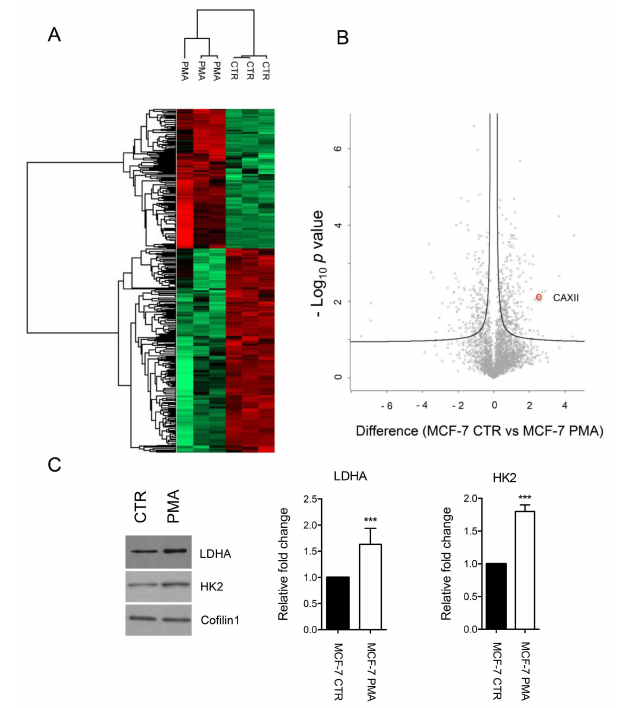
Figure 6. Mass spectrometry analysis of PMA-treated MCF-7 cells. ( A ) Heat map based on Euclidean distance that showed a significant separation between the control and PMA-treated MCF-7 cells. Color scale ranges from red to green (highest to lowest relative expression). Each column of the heat map represents an independent sample and each row represents a specific protein. ( B ) Di ff erentially expressed proteins obtained by MS / MS analysis are ranked in a volcano plot according to their statistical p -value ( y -axis) and their di ff erence (log2 fold change). CAXII is highlighted. The curve is derived at FDR = 0.05 and s0 = 0.1. ( C ) Western blot analysis and band density quantification of LDHA and hexokinase-2 (HK2) expression in control and PMA-treated MCF-7 cells. Anti-Cofilin 1 was used as loading control. Band density was measured using ImageJ. p -value *** < 0.001 by